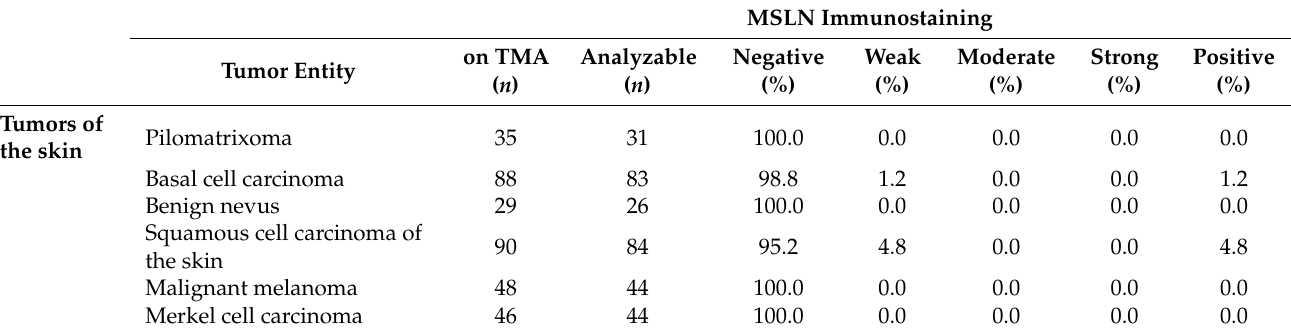
Figure 2. Pattern of MSLN immunostaining in cancer. MSLN immunostaining was found to be strong and predominantly membranous ( A ) or predominantly situated at the apical/luminal cell border ( B ) in two serous high-grade ovarian cancers, variable but predominantly apical in a cholangiocellular carcinoma ( C ), strong and predominantly cytoplasmic in a diffuse type adenocarcinoma of the stomach ( D ), strong and predominantly membranous in a malignant (epitheloid) mesothelioma ( E ), and weak to moderate, cytoplasmic and membranous in a colorectal adenocarcinoma ( F ). Table 1. MSLN immunostaining in human tumors.